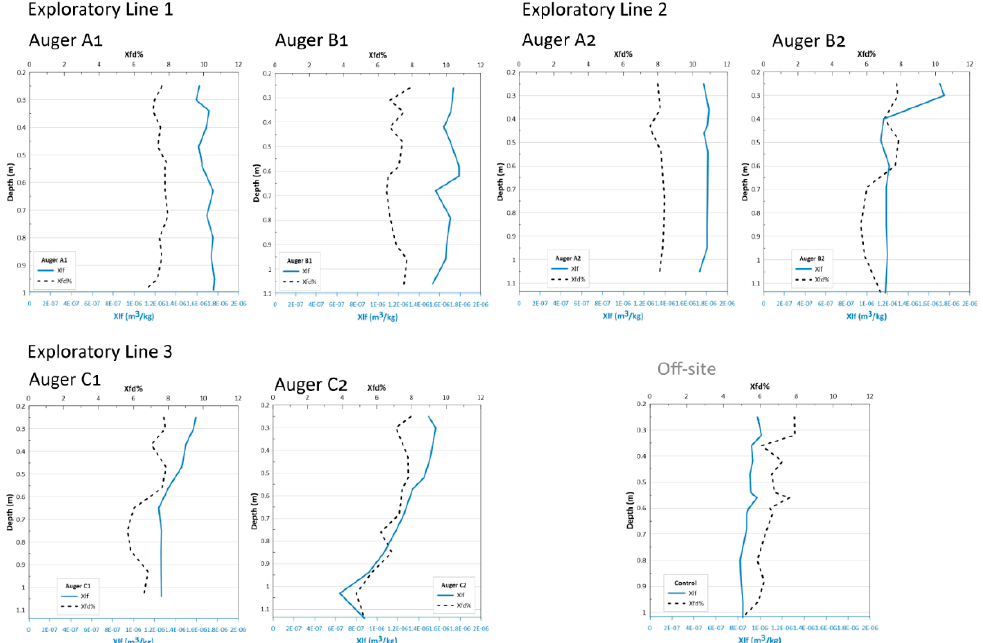
Figure 4. In-depth results of the low-frequency magnetic susceptibility ( χ lf) and frequency-dependent susceptibility of the ‘auger’ samples and off-site controls at Rizomilos. The location of the auger points in each exploratory line is shown in Figure 3.